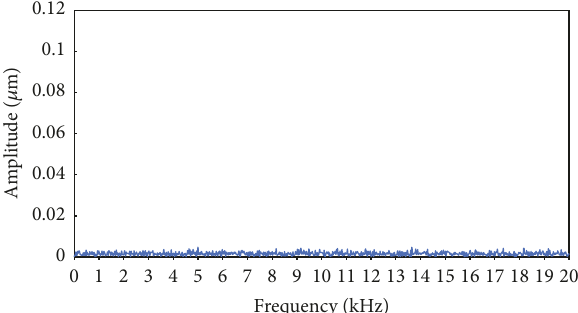
Figure 34: Spectrum of the residual signal of a healthy